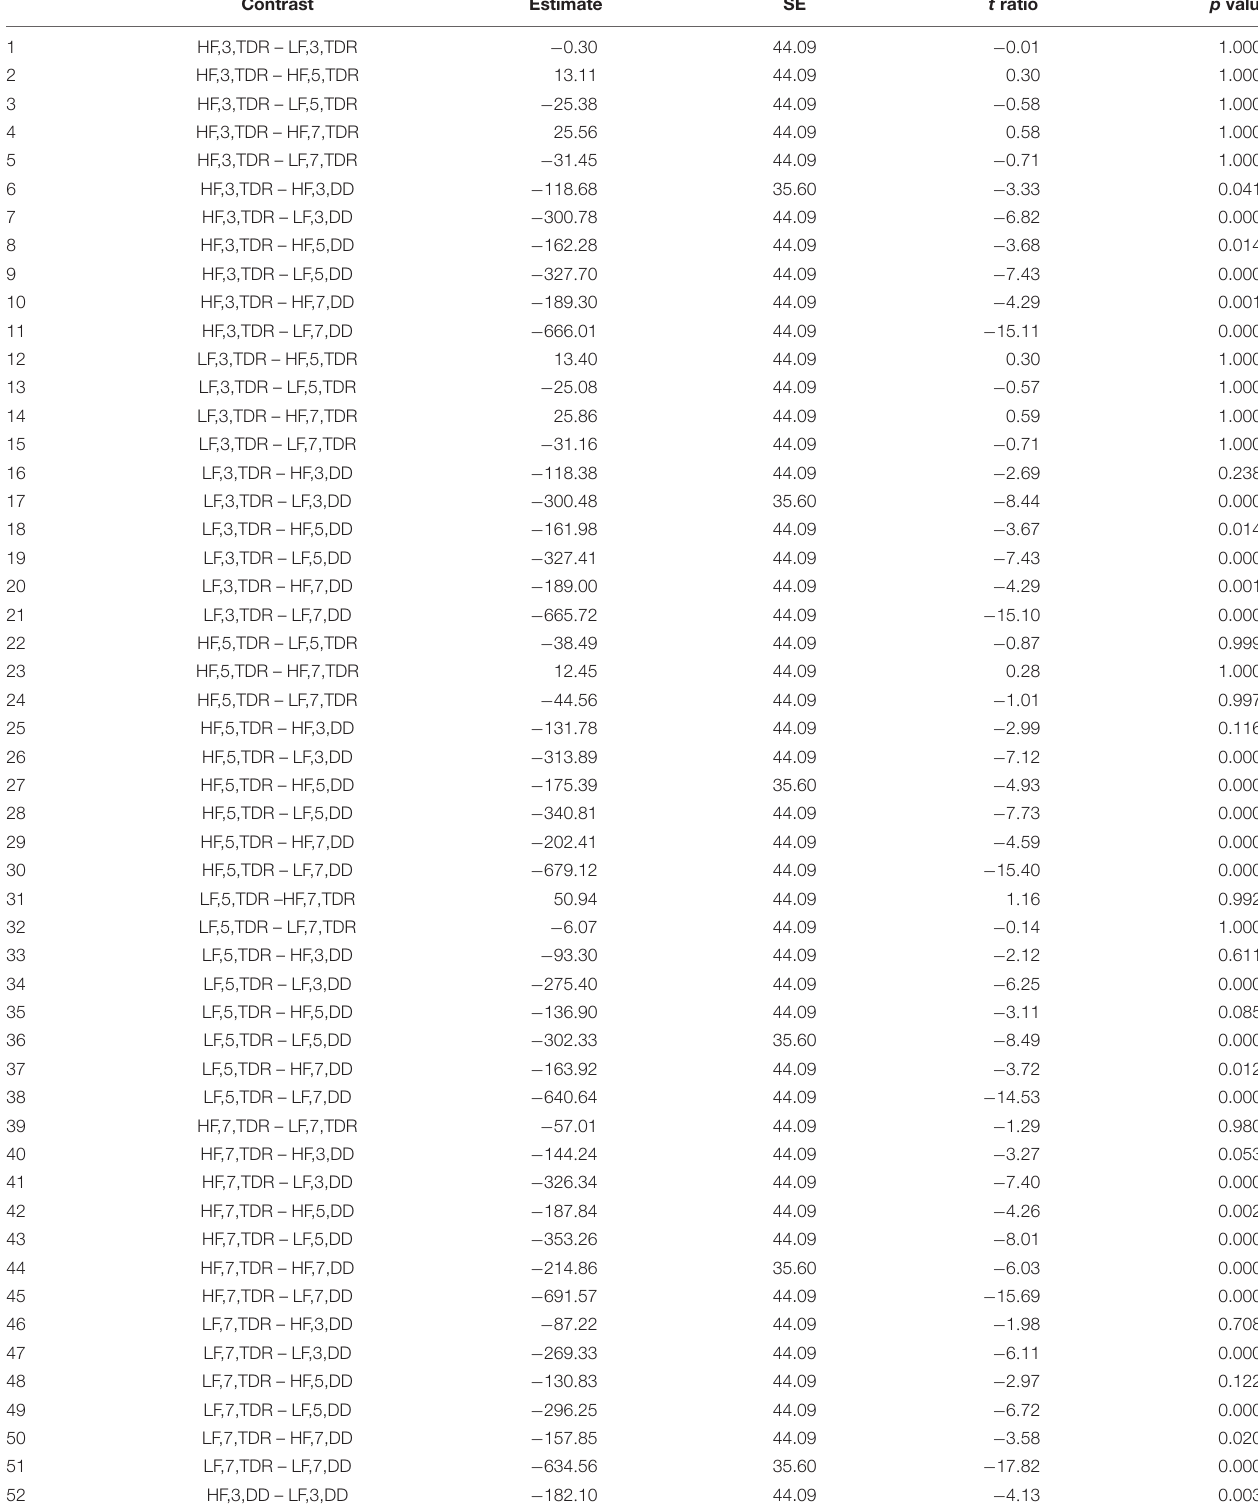
TABLE 2 | Word reading post hoc comparisons on the raw data using Tukey